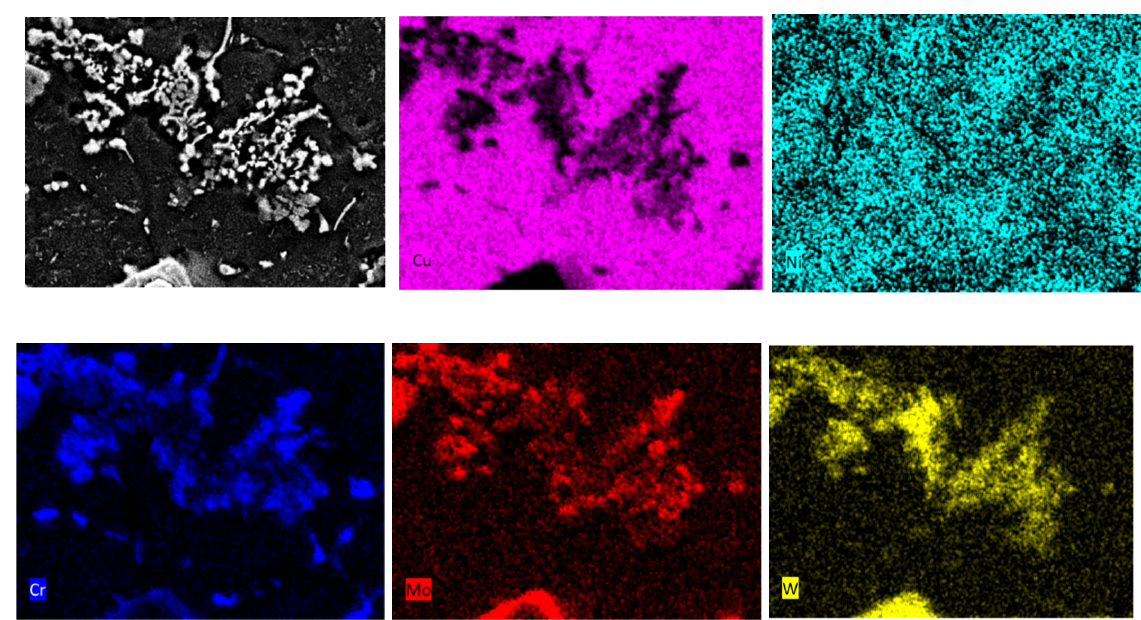
Figure 7. Surface microstructure and the corresponding EDS elemental mapping of Cu, Cr, Mo, W and Ni in alloying surface layer.